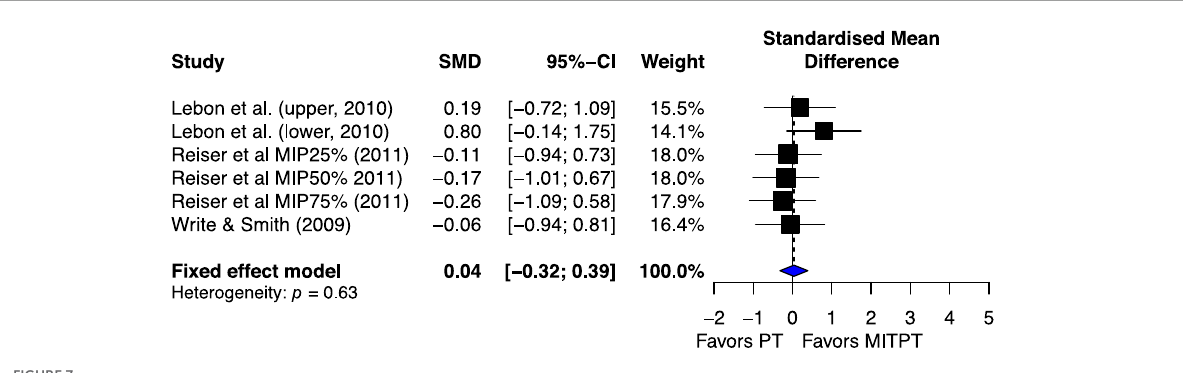
FIGURE7 Effects on maximal muscle strength: Mental imagery training combined with physical training (MITPT) vs. physical training